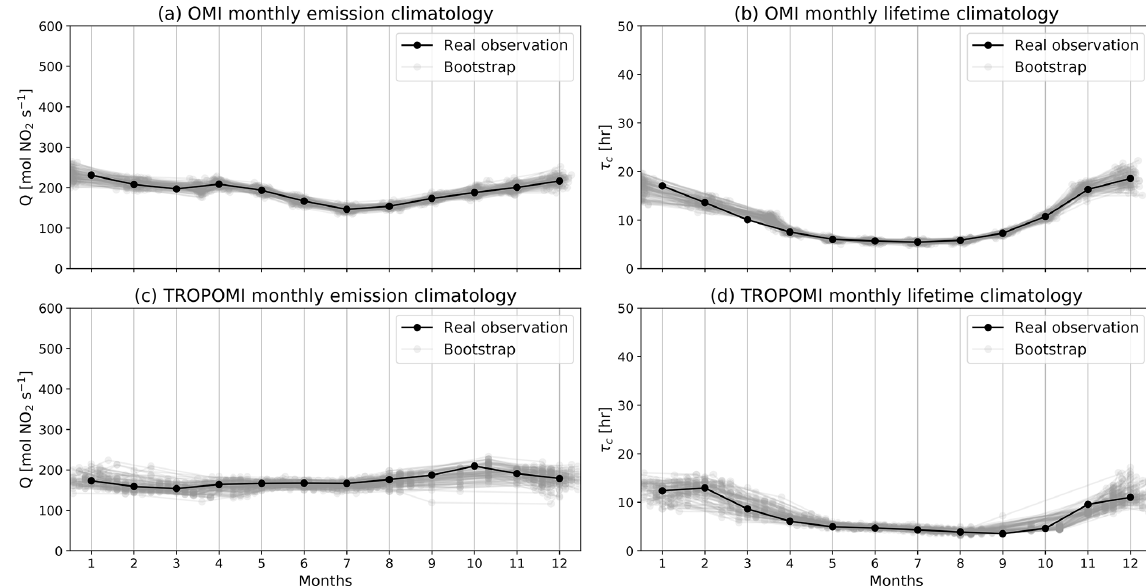
Figure 7. Similar to Figs. 4 and 6, but using Bayesian optimal estimation incorporating the prior knowledge that the climatological emission rates and lifetimes should vary